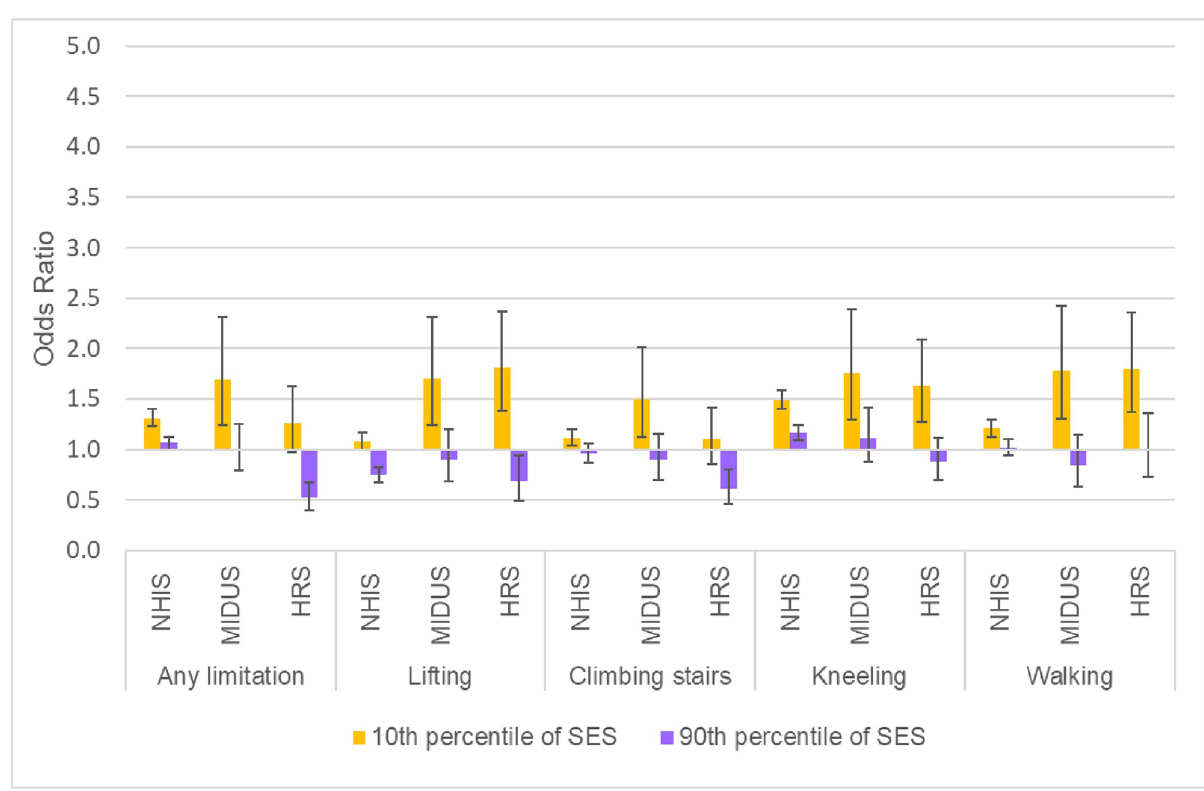
Fig 3. Period change in physical limitations at age 50 for 10 th vs. 90 th percentile of SES. These results are based on the models shown in Tables F, H, and J in S1 Appendix.